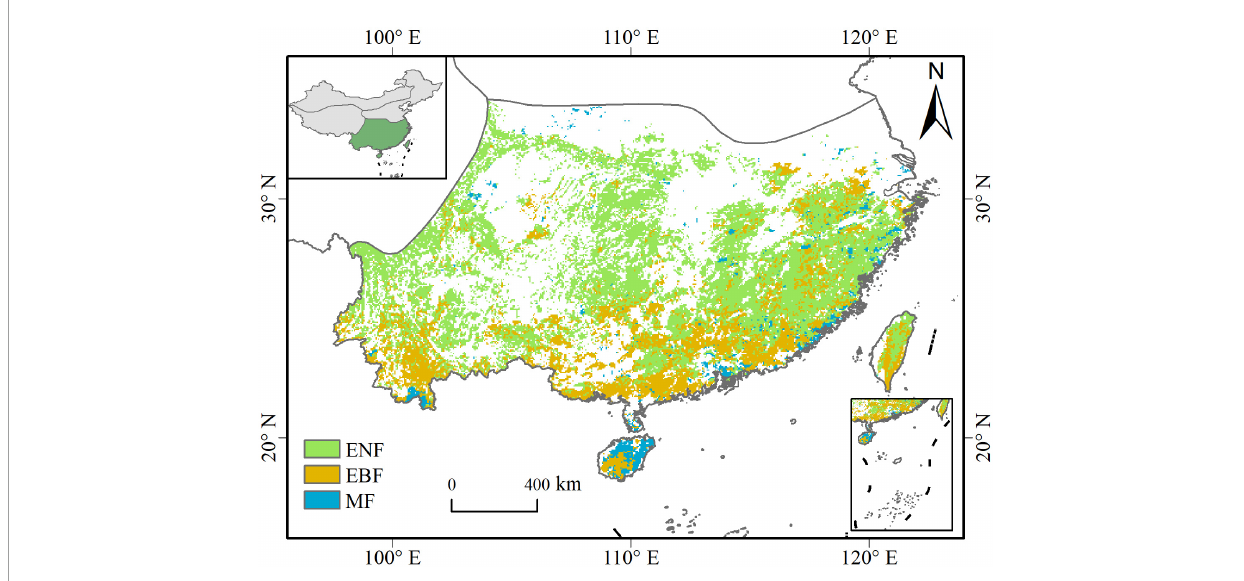
FIGURE1 Distribution of evergreen forests in Southern China. ENF, evergreen needleleaf forests; EBF, evergreen broadleaf forests; MF, mixed